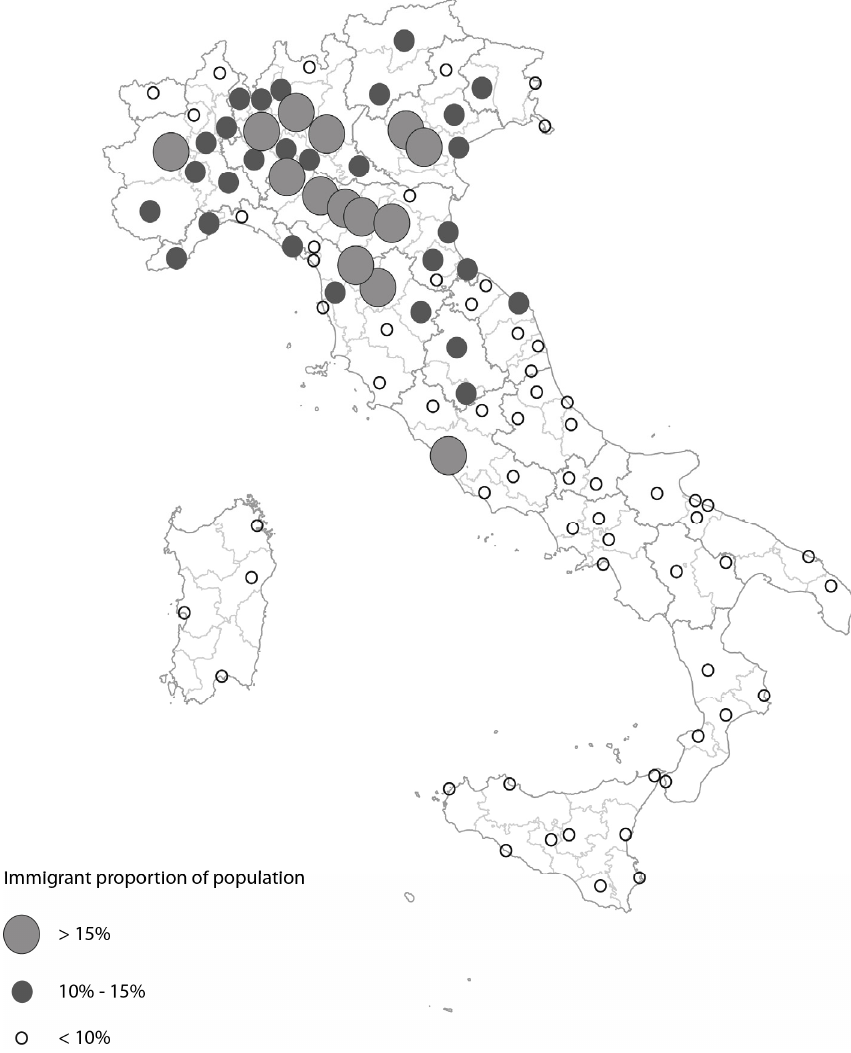
Figure 1. Proportions of immigrants in the populations of 112 provincial capitals